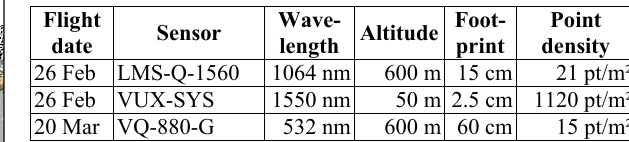
Table 2. Specifications of the used laser scanner systems